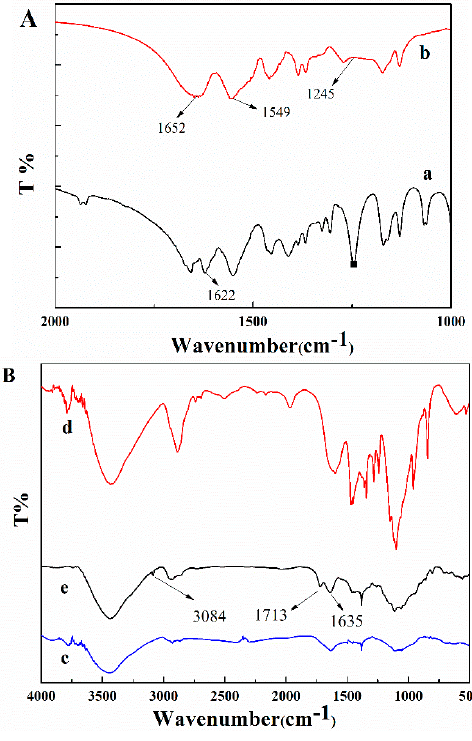
Figure 4. ( A ): The FT-IR spectra (2000–1000 cm − 1 ) of ( a ) NIPAM powders; ( b ) PNIPAM powders; ( B ): The FT-IR spectra ( 4000–500 cm − 1 ) of ( c ) Sericin/PNIPAM/PEO nanofibers; ( d ) Cotton fabric; ( e ) Functionalized cotton fabric.